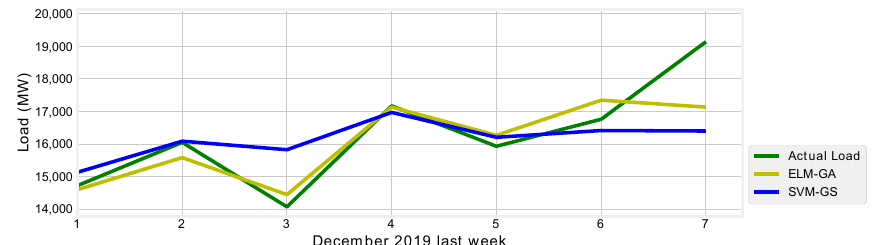
Figure 11. One week prediction (1 December 2019 to 7 December